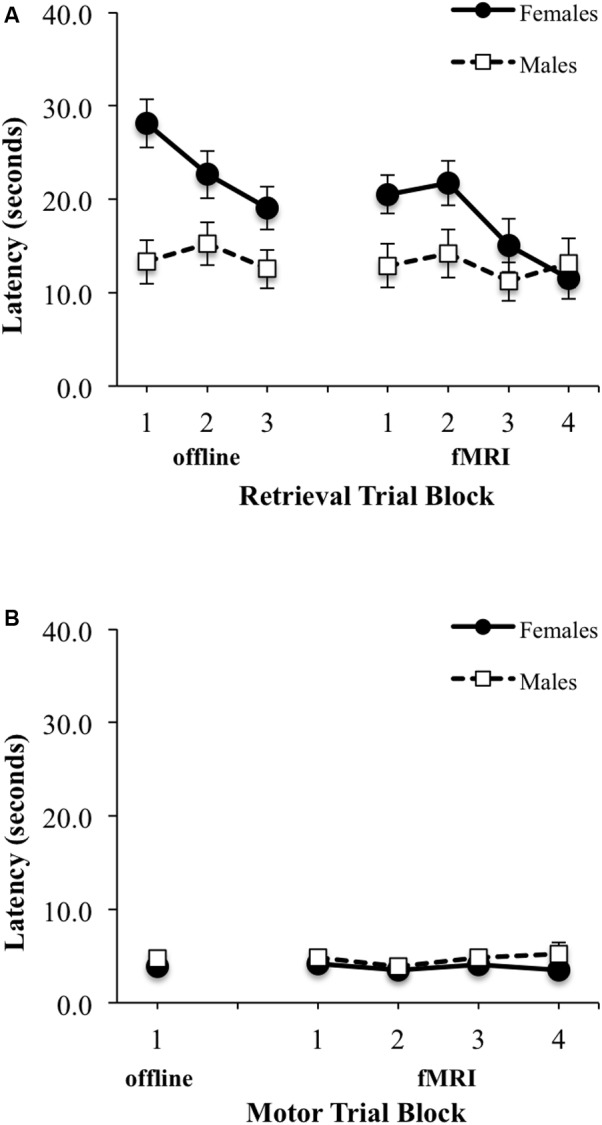
Latency (seconds) to reach the platform during: (A) three offline (left) and four fMRI (right) retrieval/hidden trial blocks; (B) one offline (left) and four fMRI motor/visible trial blocks. Females are represented as filled black circles with solid lines and males are represented as open squares with dotted lines.